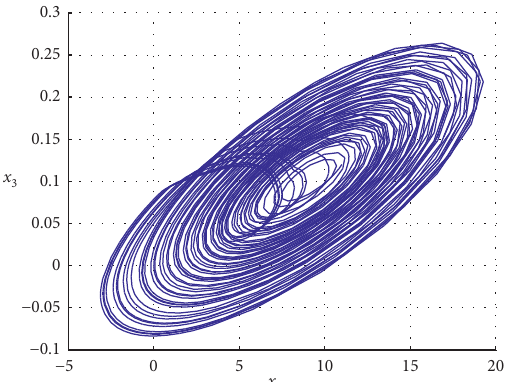
Figure 2: Two-dimensional projection of the chaotic neural net- work system on x 1 x 2 -coordinate plane.